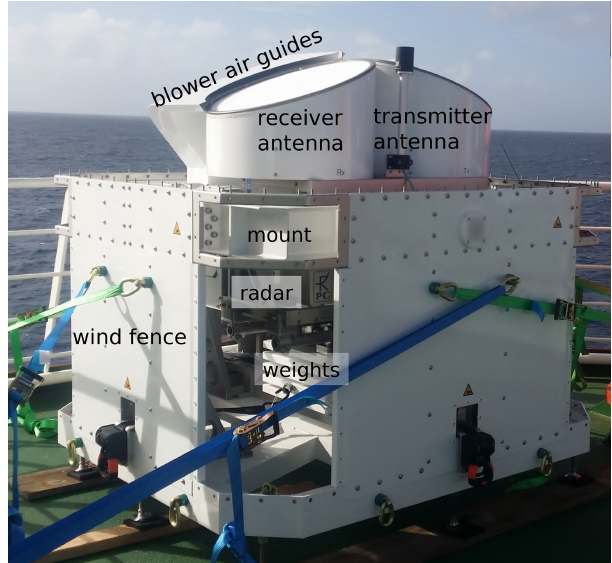
Figure 1. 94GHz FMCW cloud radar “LIMRAD94” inside the car- danic mount. Specific parts of the radar and the cardanic mount are labeled. Photo taken by Heike